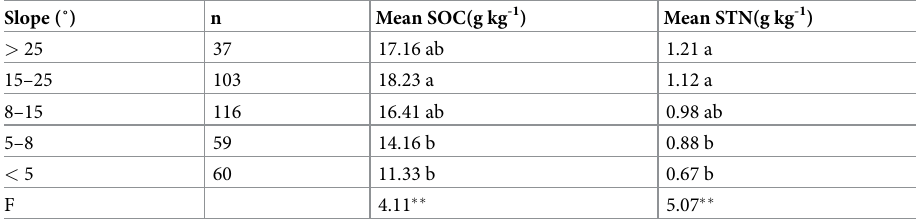
F 5.07 �� Different letters in the same column indicate significant difference at P < 0.01. �� P <